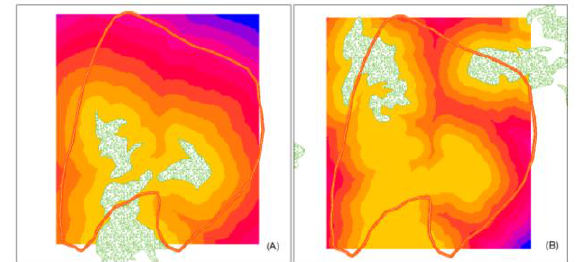
Figure 6. (A) Source Cost Distance Raster and (B) Destination Cost Distance Raster